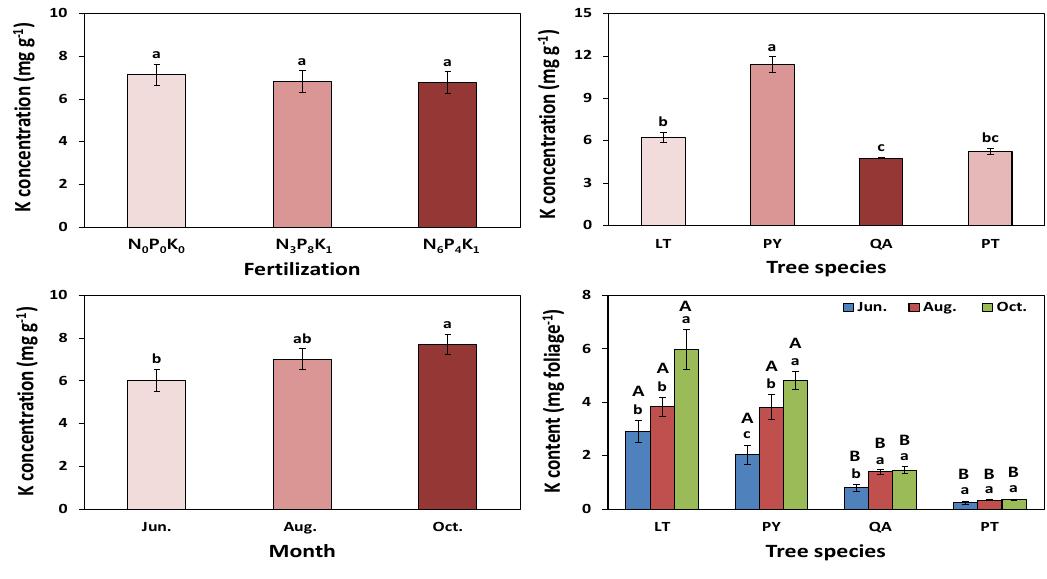
Figure 8. Potassium concentration and content of foliage by tree species, fertilization and sampling month in a fire-disturbed urban forest (mean ± standard error). Treatment means with the same lower case letter among fertilizer, tree species or sampling month treatments and treatment means with the same upper case letter among tree species are not significantly different at p < 0.05. LT: Liriodendron tulipifera L.; PY: Prunus yedoensis Matsumura; QA: Quercus acutissima Carruth; and PT: Pinus thunbergii